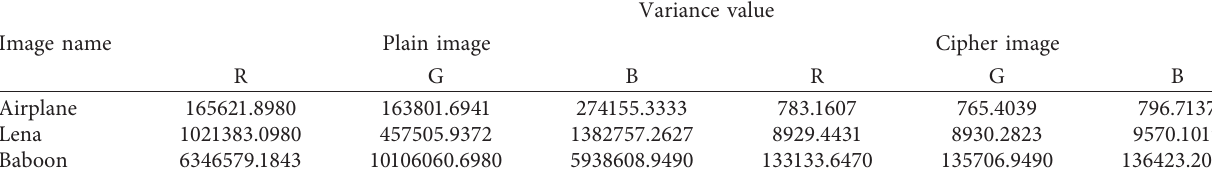
Table 4: Variance of histogram for encrypted color